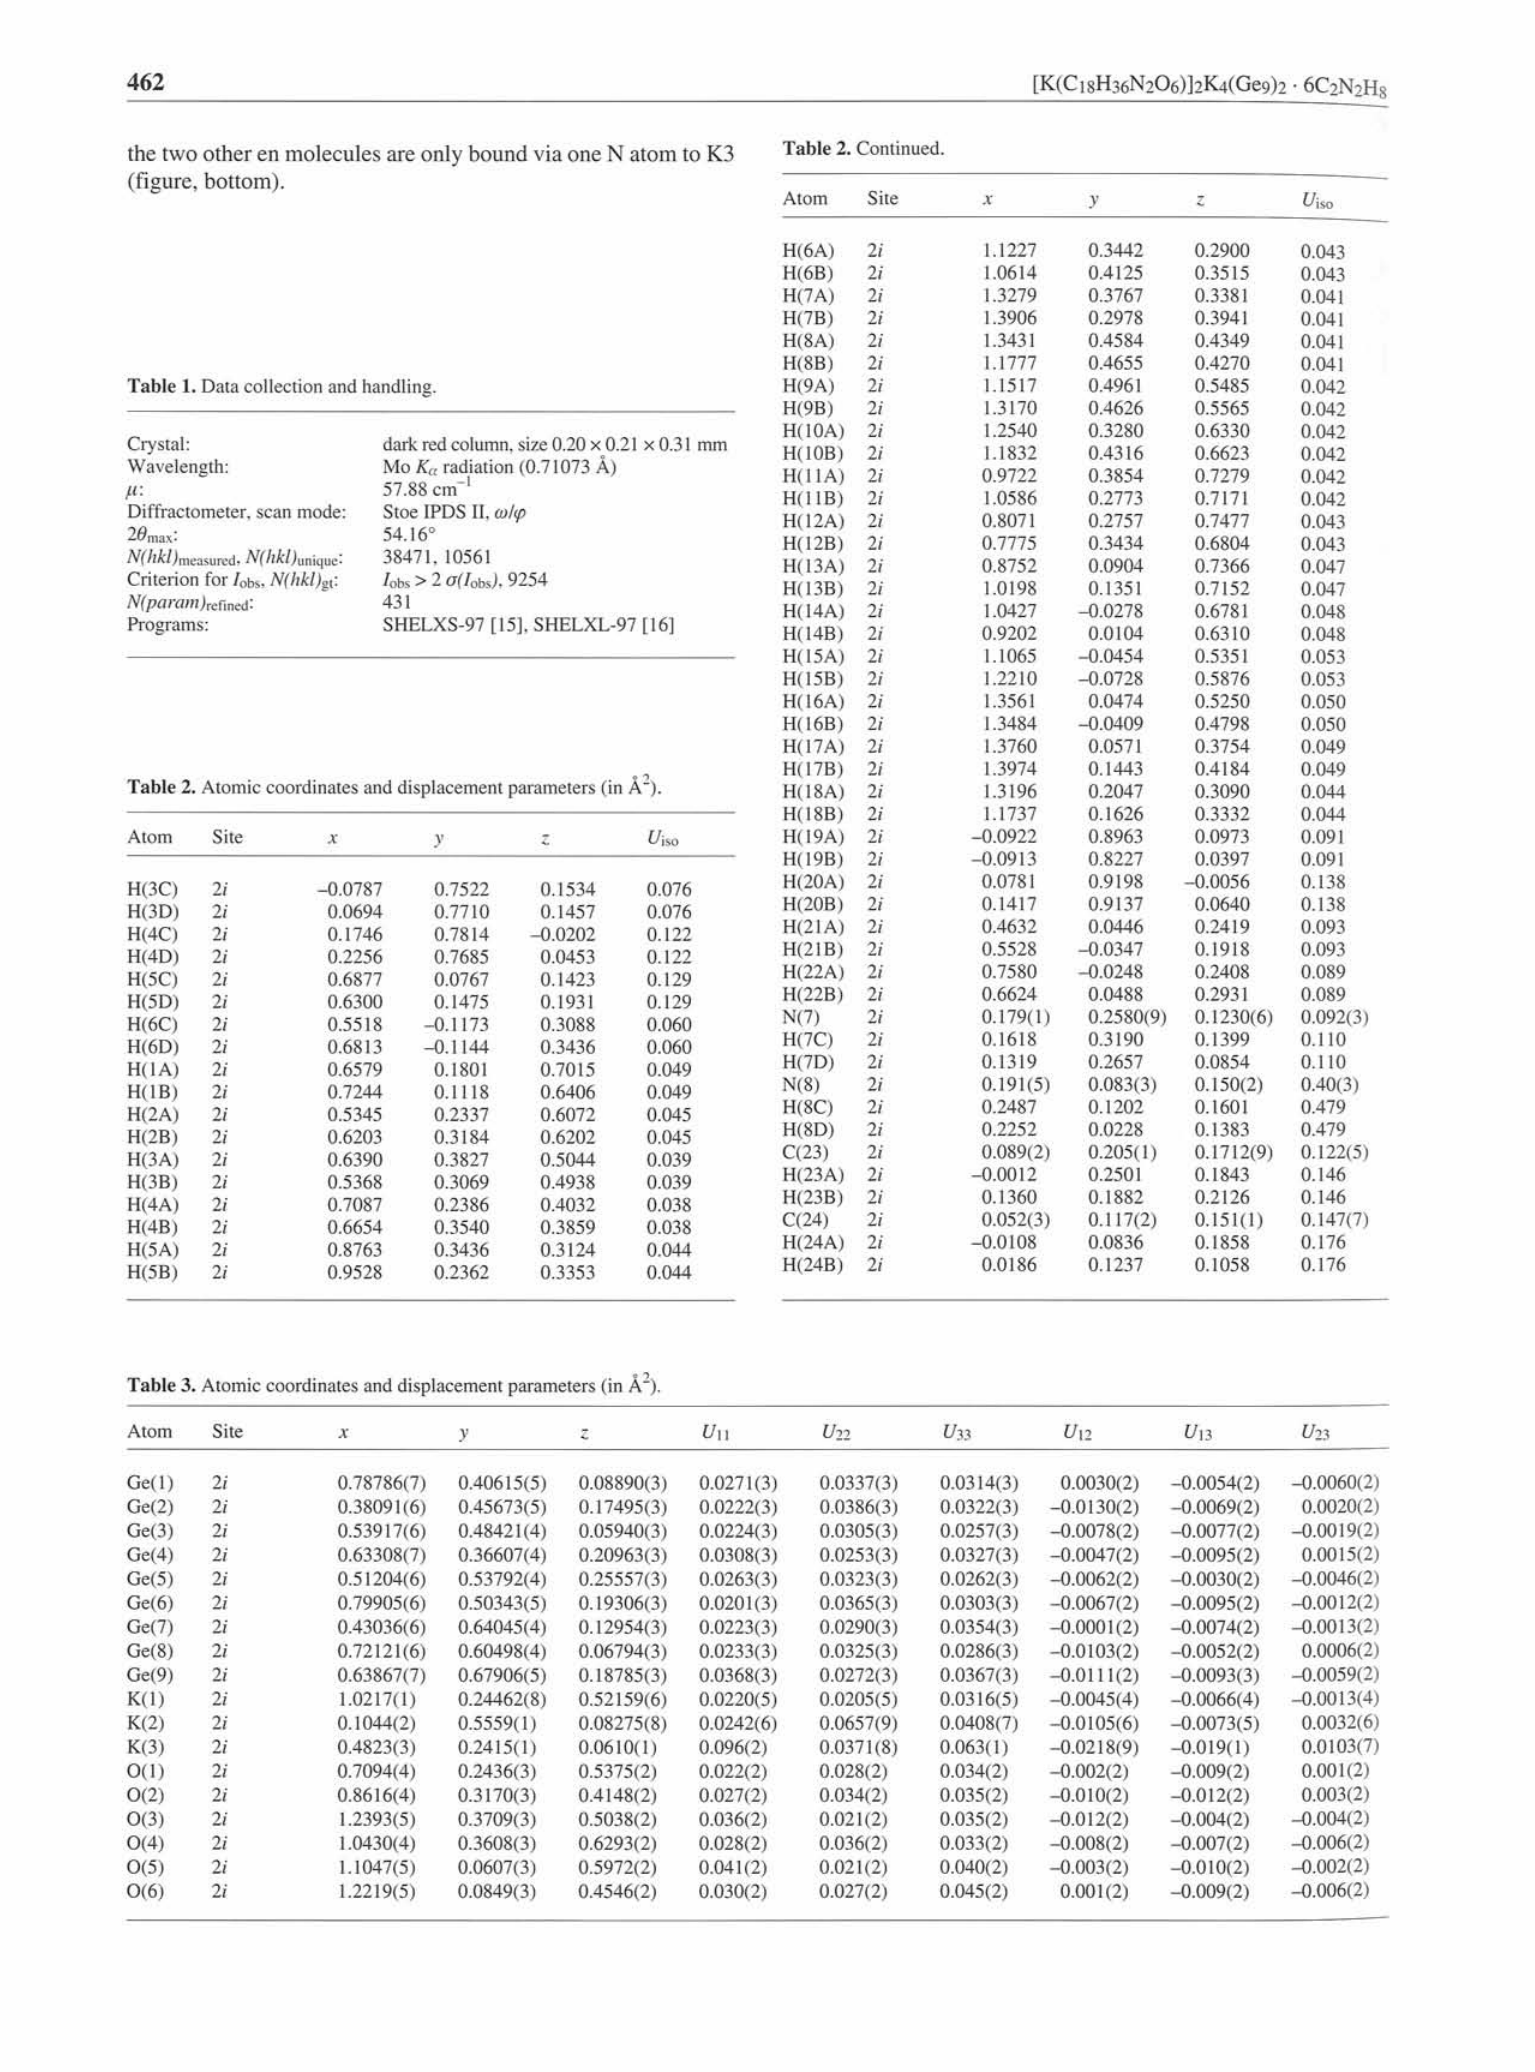
Table 3. Atomic coordinates and displacement parameters (in Â 2